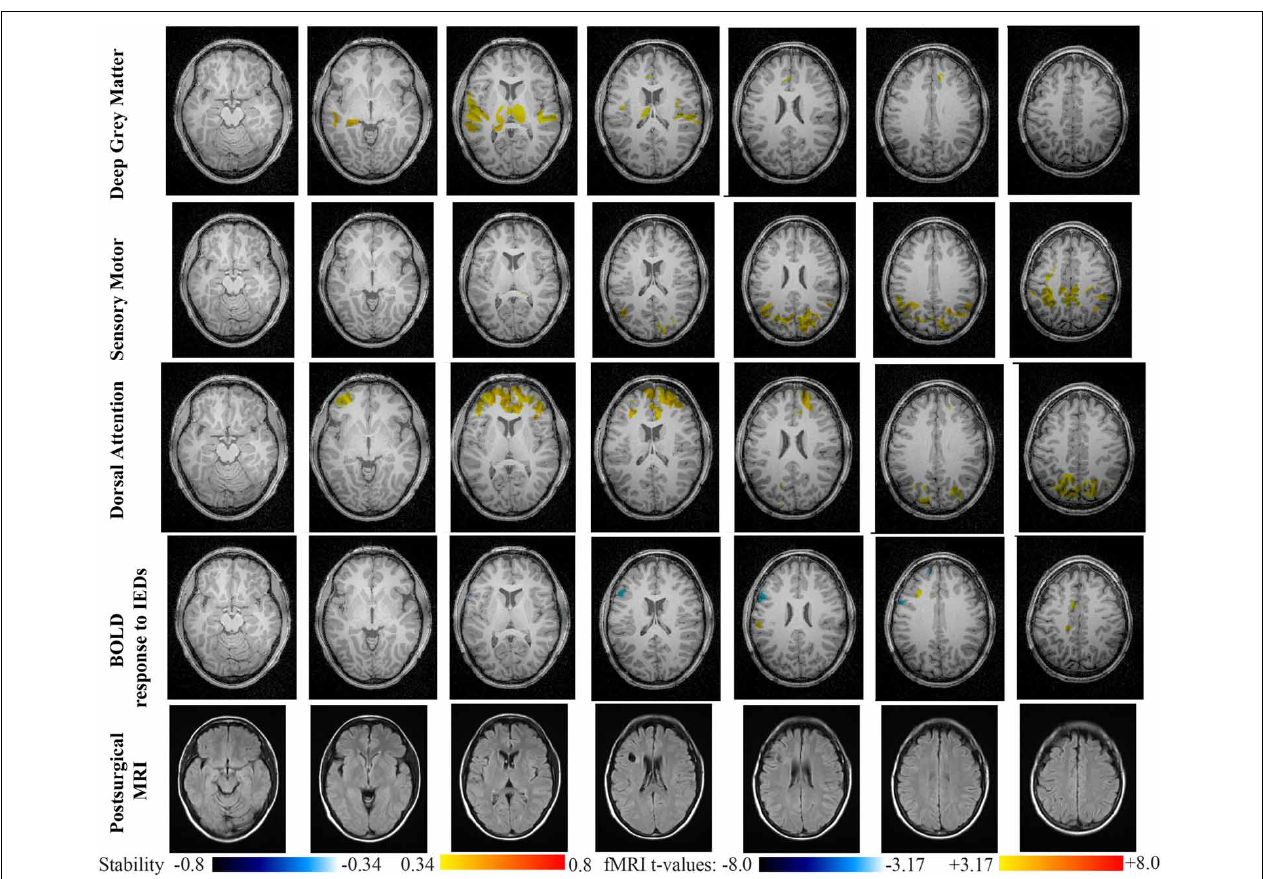
the patient. Most salient stability changes observed for Cmap n of Deep Gray Matter, Sensory Motor, and Dorsal Attention networks are presented. No networks were involved in significant interactions of modularity changes at p < 0 . 001. Same colormap conventions than in Figure 6